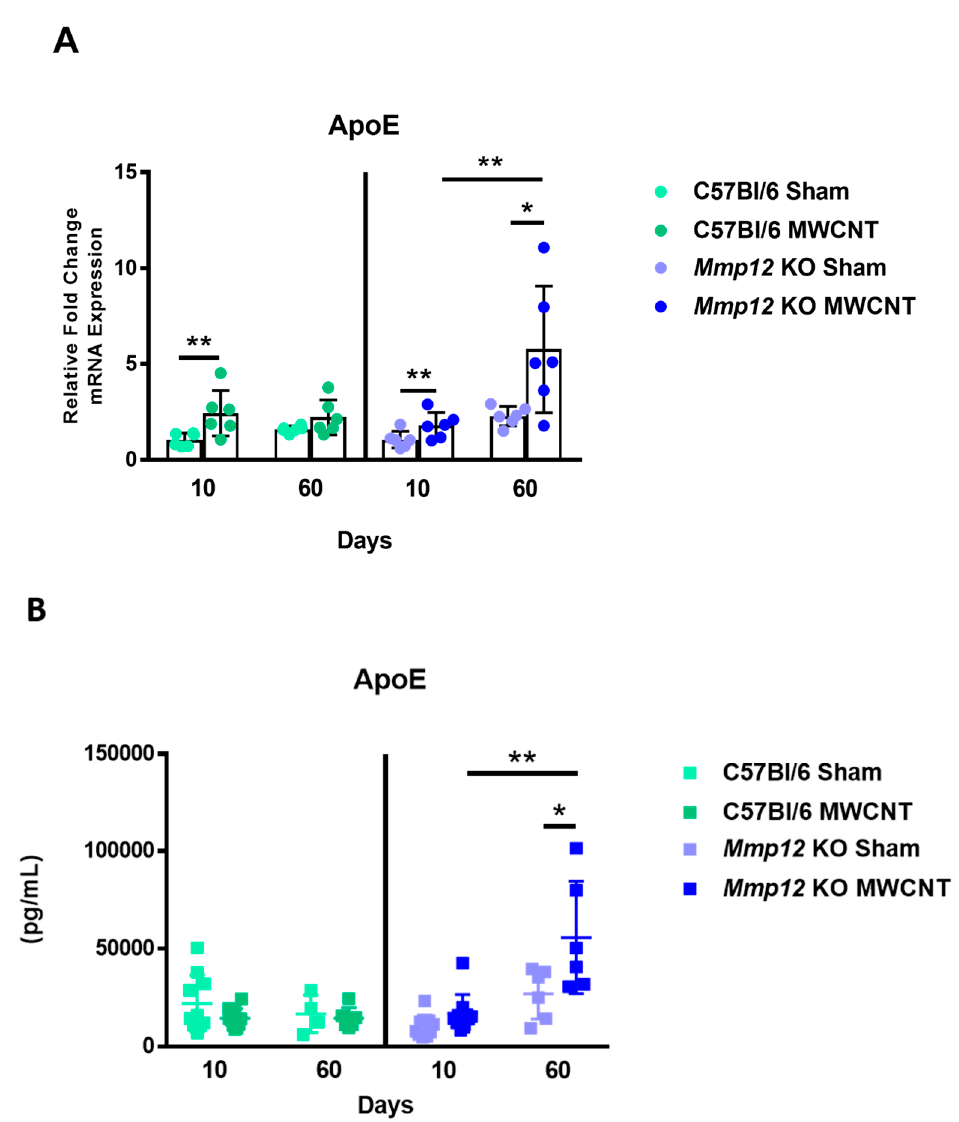
Figure 5. ApoE gene and protein levels are increased in MWCNT-instilled Mmp 12 KO mice at 60 days. ( A ) ApoE gene expression was increased in MWCNT-instilled C57Bl/6 at 10 days, and in Mmp 12 KO mice at both time points from BAL cells. ApoE was not increased in MWCNT-instilled C57Bl/6 mice relative to sham at 60 days. ApoE expression in MWCNT-instilled Mmp 12 KO was increased at 60 days relative to 10 days (* p ≤ 0.05; ** p ≤ 0.01; n ≥ 5/group). ( B ) ApoE BALF protein levels were increased in MWCNT-instilled 60-day Mmp 12 KO relative sham (* p ≤ 0.05; ** p ≤ 0.01; n ≥